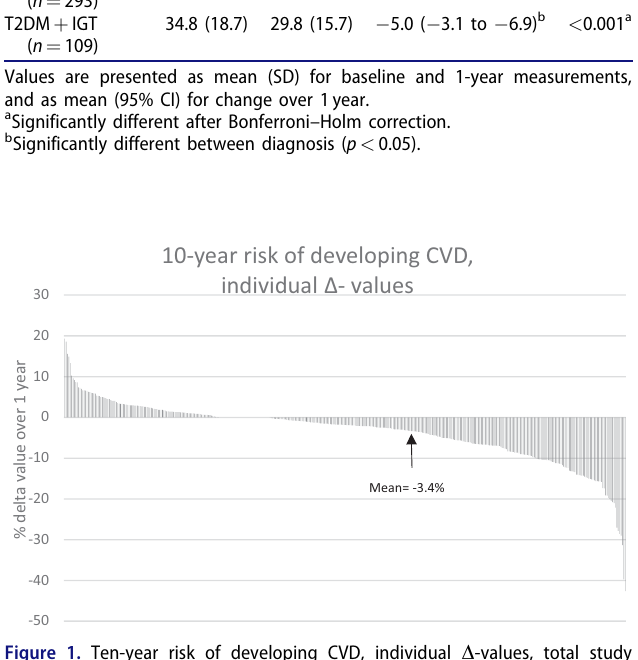
Figure 1. Ten-year risk of developing CVD, individual D -values, total study population ( n ¼